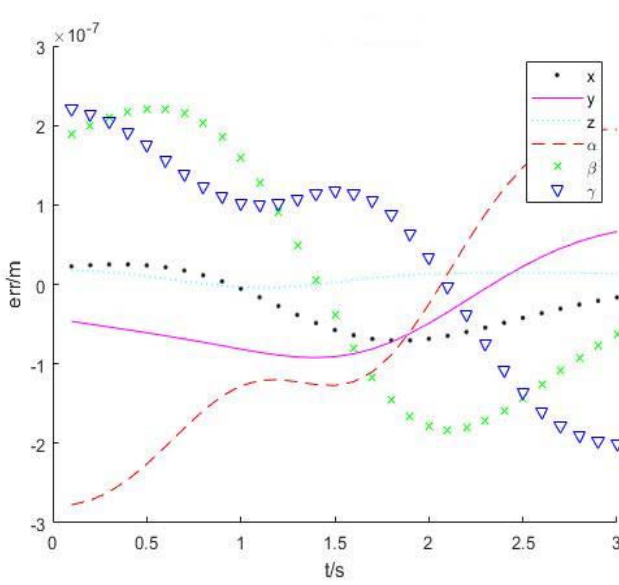
Figure 6. Numerical inverse solution error.